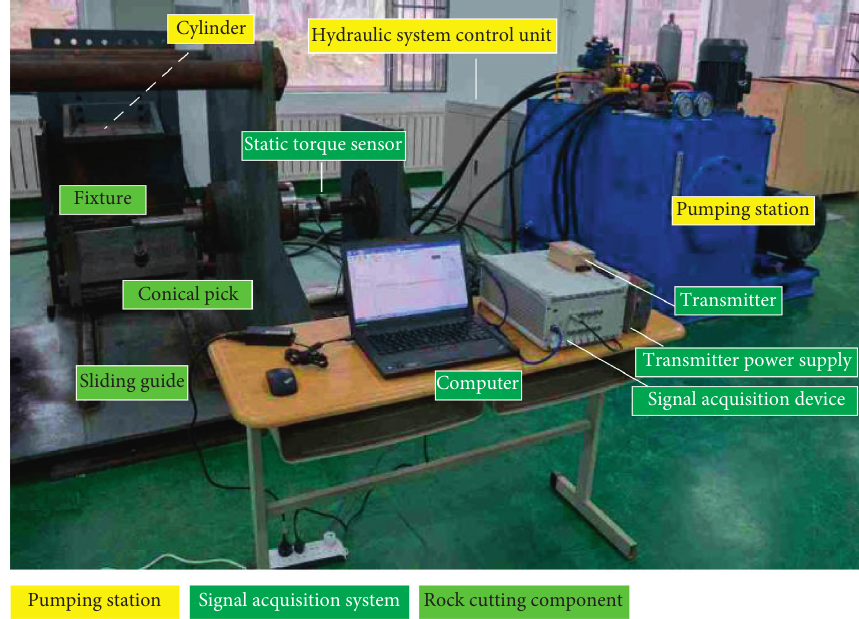
Figure 8: Rock plate cutting test